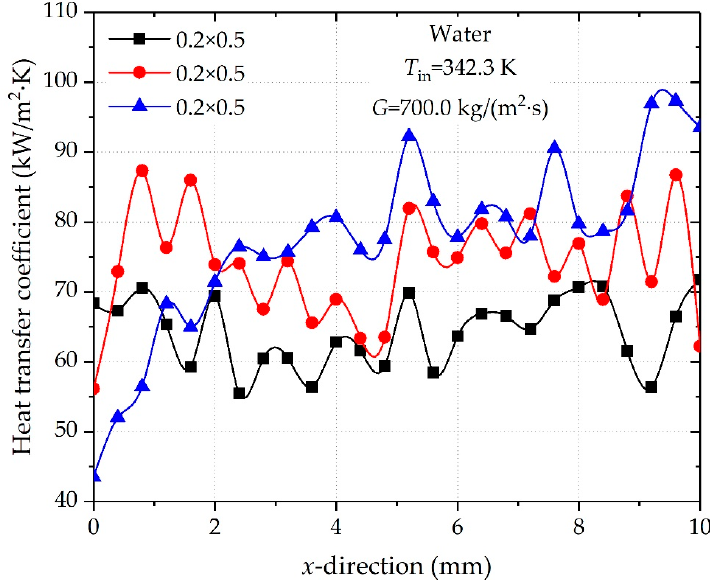
Figure 10. Variations in the local heat transfer coefficient along the flow stream for different channel heights. channel